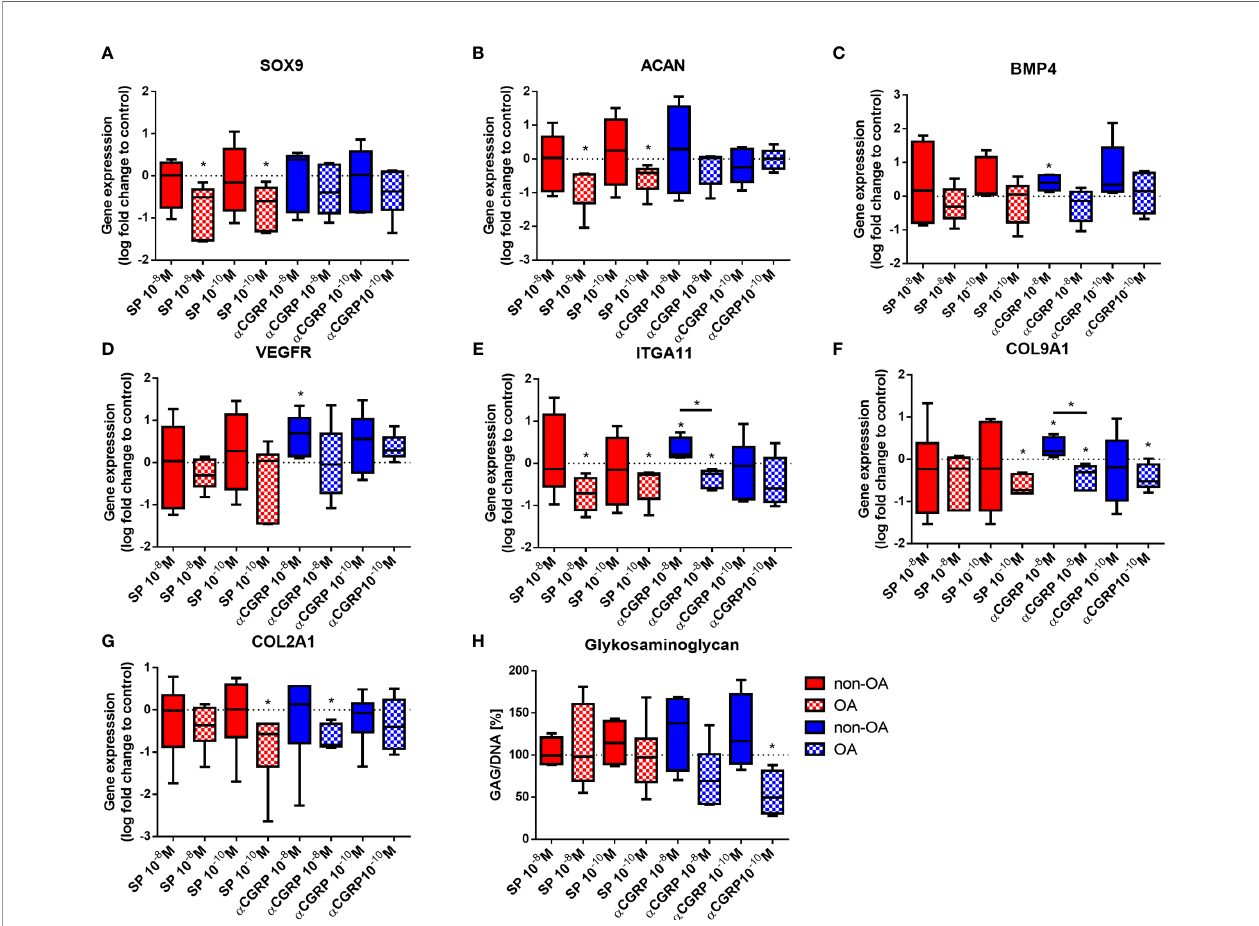
FIGURE 4 | Expression of chondrogenic and mesenchymal markers in 3D fi brin gels cultured OA- and non-OA chondrocytes after stimulation with SP and a CGRP. Chondrocytes were treated with either 10 -8 or 10 -10 M SP or a CGRP for 7 days and then compared to the respective untreated control cells (untreated controls set to 0 or 100% = dotted line). (A – G) Quantitative RT-PCR analysis revealed the gene expression of SOX9, ACAN, BMP4, VEGFR, ITGA11, COL9A1 and COL2A1. (H) The glycosaminoglycan (GAG) content in OA and non-OA chondrocytes was analysed with a DMMB assay. Results show median (min to max); one sample t-test; *p ≤ 0,05; n =